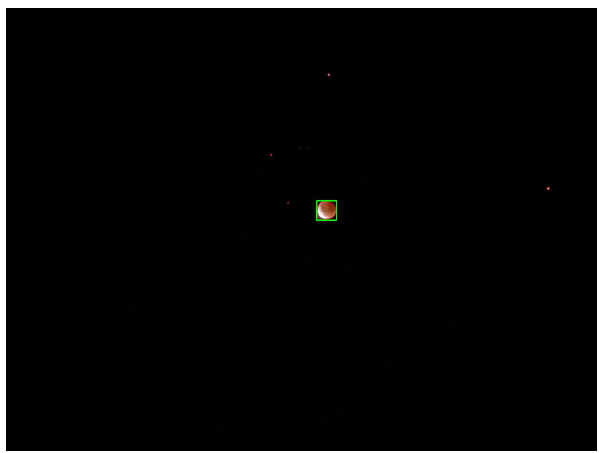
Figure 11. Moon computer vision tracking. Contours in the image are highlighted in red, with the largest one enclosed by a green rectangle. The centre of this rectangle can then be further used as the centre of the